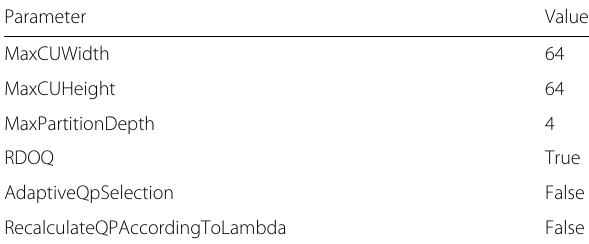
HCOST MODE value greater